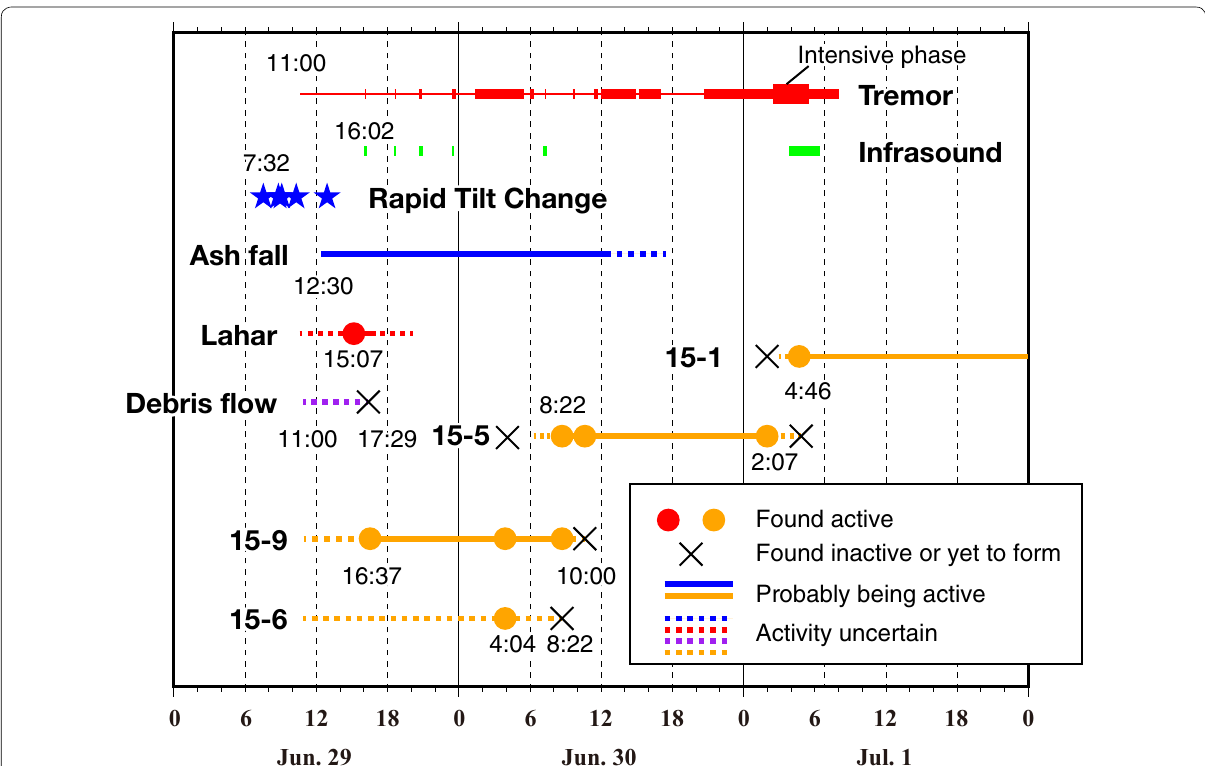
Fig. 19 Time sequence of the 2015 Hakone eruption. The first signal observed was a rapid tilt change (RTC) at 7:32 on June 29. Erosion of the stream bed, probably due to lahar and/or debris flow, tremor, ash fall and infrasound followed. Note that activity at craters relayed as new craters formed and at the last timing of relay, intensive phases of tremor and infrasound were